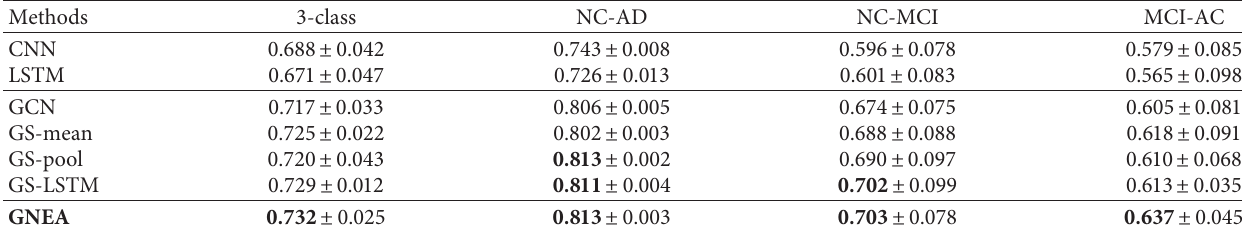
Figure 8: Performance evaluation of fully connected layers. (a) AUC. (b) Runtime. Table 1: Performance comparison of AUCs with a 95% CI on different